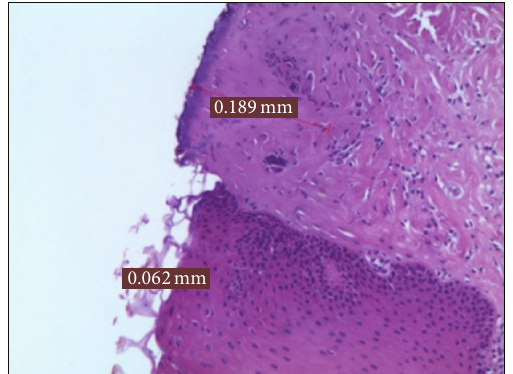
Figure 3: Histological specimen C 2 , using 4 watt in CW, colour EE, magnification from original 40x.